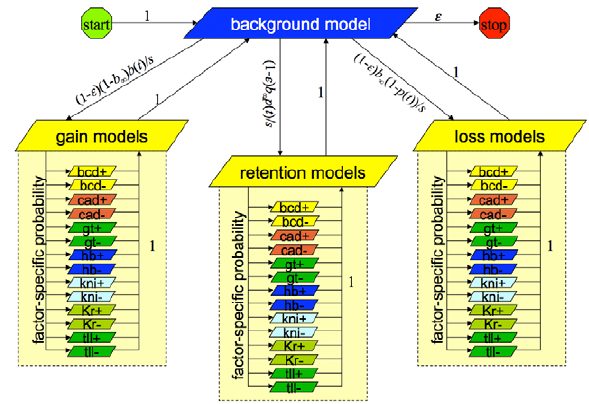
Figure 3. An example CRM evolution model that can be implemented in our framework. Parallelograms denote groups of states in the PPHMM; small parallelograms denote states implementing a binding site profile (positional weight matrix). b ( t ): gain probability. q ( t ): loss probability. p ( t ): retention probability. b ‘ : limit of b ( t ) as t R ‘ . t : branch length. s : 1 - (1 - b ‘ )(1 - b ( t )). e : 0.00001. Plus and minus denote strand. See Materials and Methods for additional details.